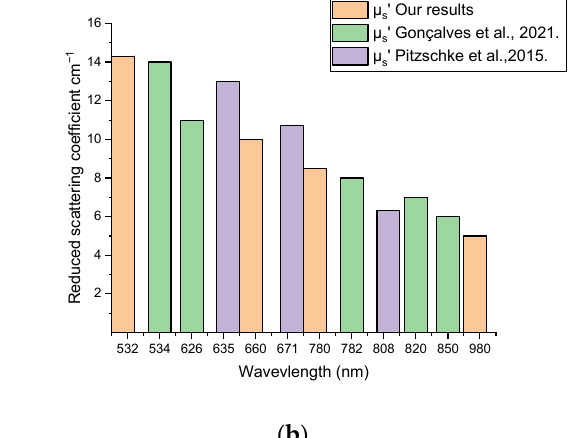
Figure 13. Comparison with the data from the literature Gonçalves et al. [29] and Pitzschke et al. [37] measured using the absorption coefficient µ a ( a ) and reduced scattering coefficient μ (cid:2929)(cid:4593) ( b ) of the rabbit brain.